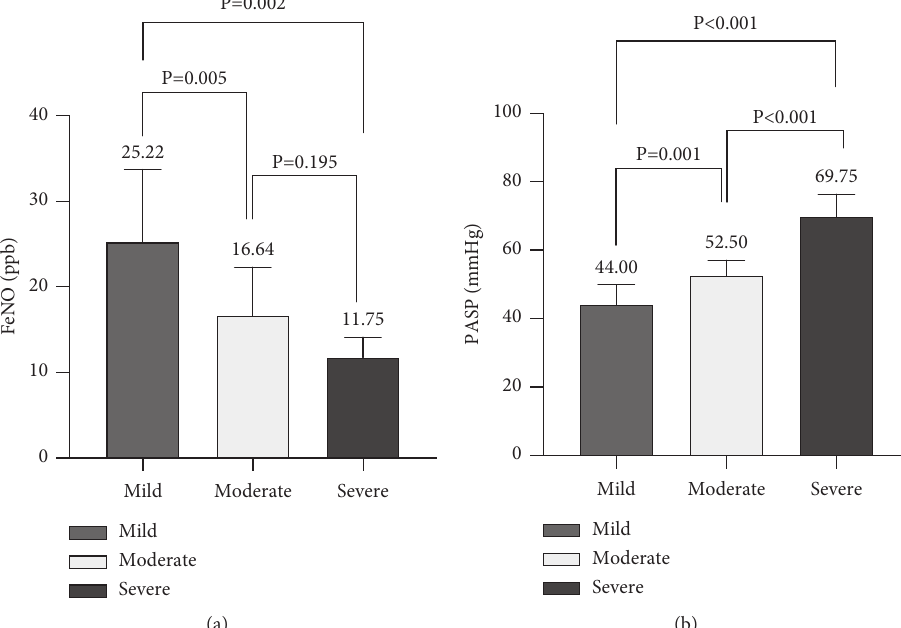
Figure 1: (a) FeNO and (b) PASP levels in patients with mild, moderate, or severe PH in the AECOPD+PH group. FENO, fractional exhaled nitric oxide; PH, pulmonary hypertension; PASP, pulmonary arterial systolic